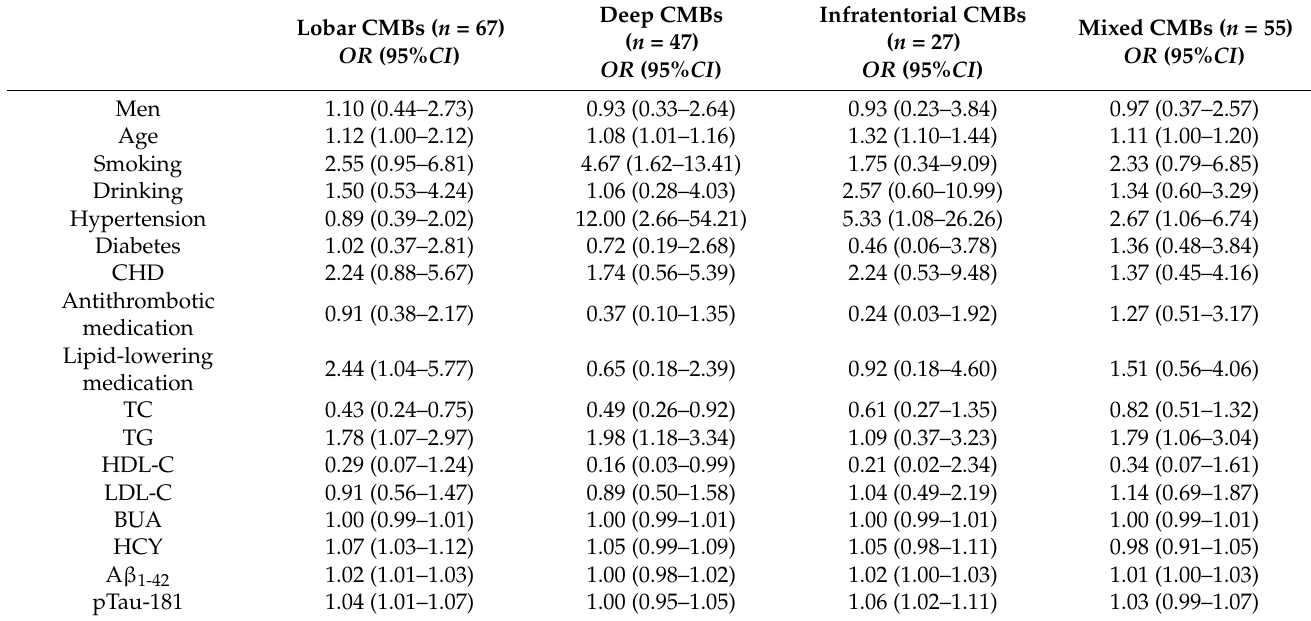
Table 3. The analysis of the risk factors for CMBs in different regions.